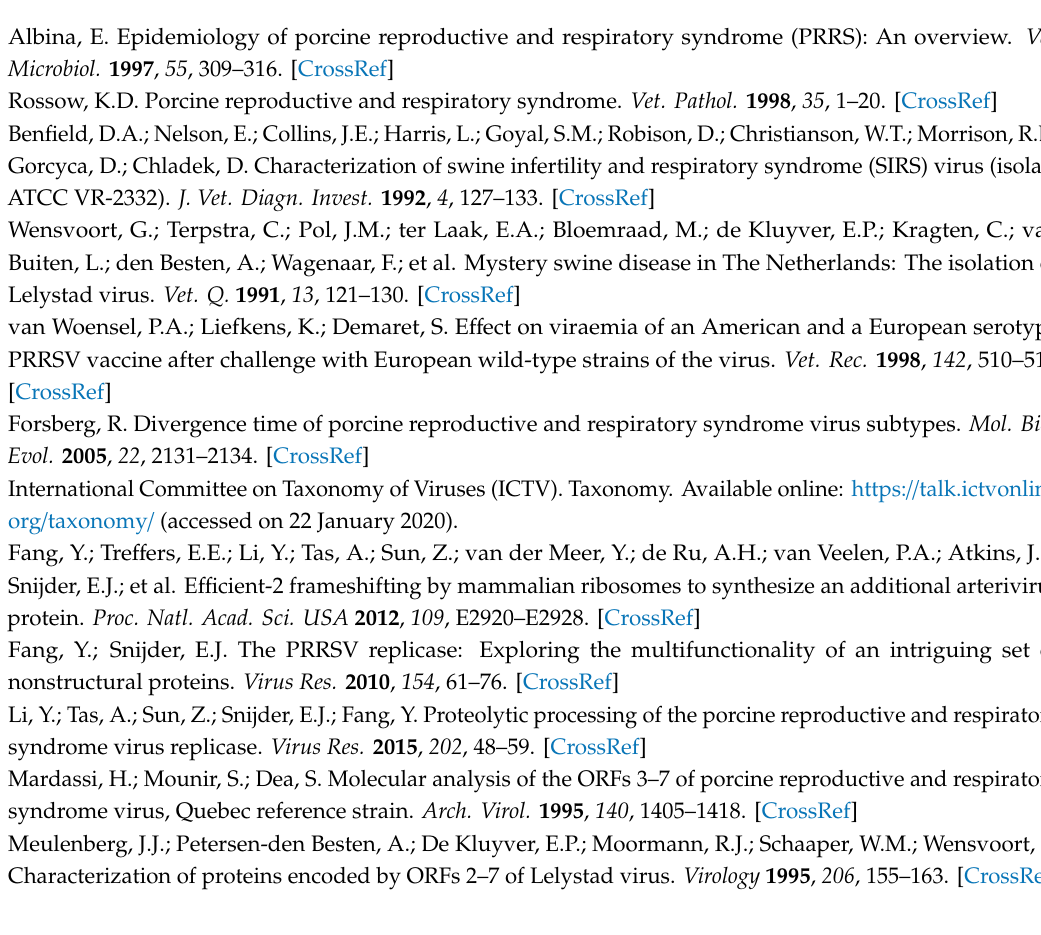
Figure S1: Structural comparisons of methylated nsp10, truncated nsp10, PRRSV nsp10, and EAV nsp10. Figure S2: ATPase activities of PRRSV nsp10 and EAV nsp10 were determined from Lineweaver-Burk plots of hydrolysis activity using the malachite green assay. Figure S3: Structural characterization of the PRRSV nsp10 ZBD. Figure S4: Putative protein interaction surface of the nsp10 ZBD. Figure S5: Validation of the nucleic acid binding ability of PRRSV nsp10. Figure S6: Structural comparison of PRRSV nsp10-DNA complex and holo PRRSV nsp10. Figure S7: Comparison of holo nsp10 and complex model with SAXS experimental data of nsp10-DNA complex. Table S1: Pairwise comparison of the isolated ZBD / CH, 1B, 1A / RecA1, 2A / RecA2 and helicase core (1A / RecA1&2A / RecA2) domains of PRRSV nsp10, EAV nsp10 and MERS-CoV nsp13. Table S2: SAXS data collection and analysis. Table S3: Examples of insoluble